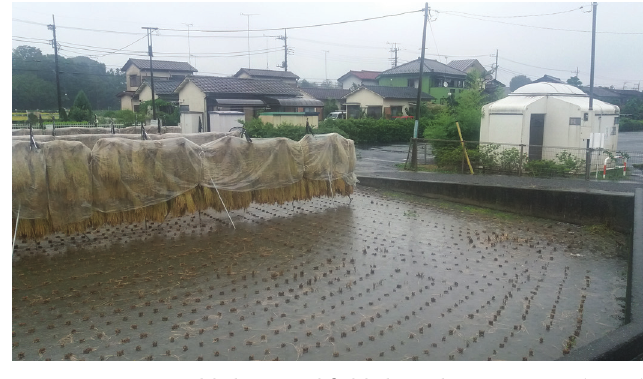
Fig. 5. Concrete paddy levee and field along the Tama River (Fussa) providing minimal habitat for Orthoptera. Photo by